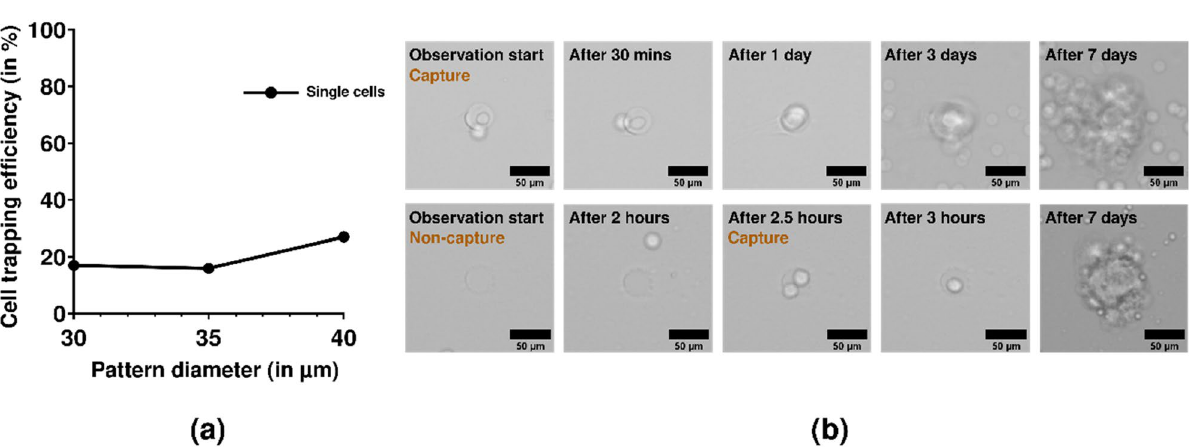
Figure 6. Cell trapping efficiency and the growth of a trapped single cell. ( a ) The single-cell trapping behavior observed against the diameter size of the microwell array. ( b ) Cell viability was observed for a period of 7 days. After 7 days of incubation inside the microwell, cells divided in both